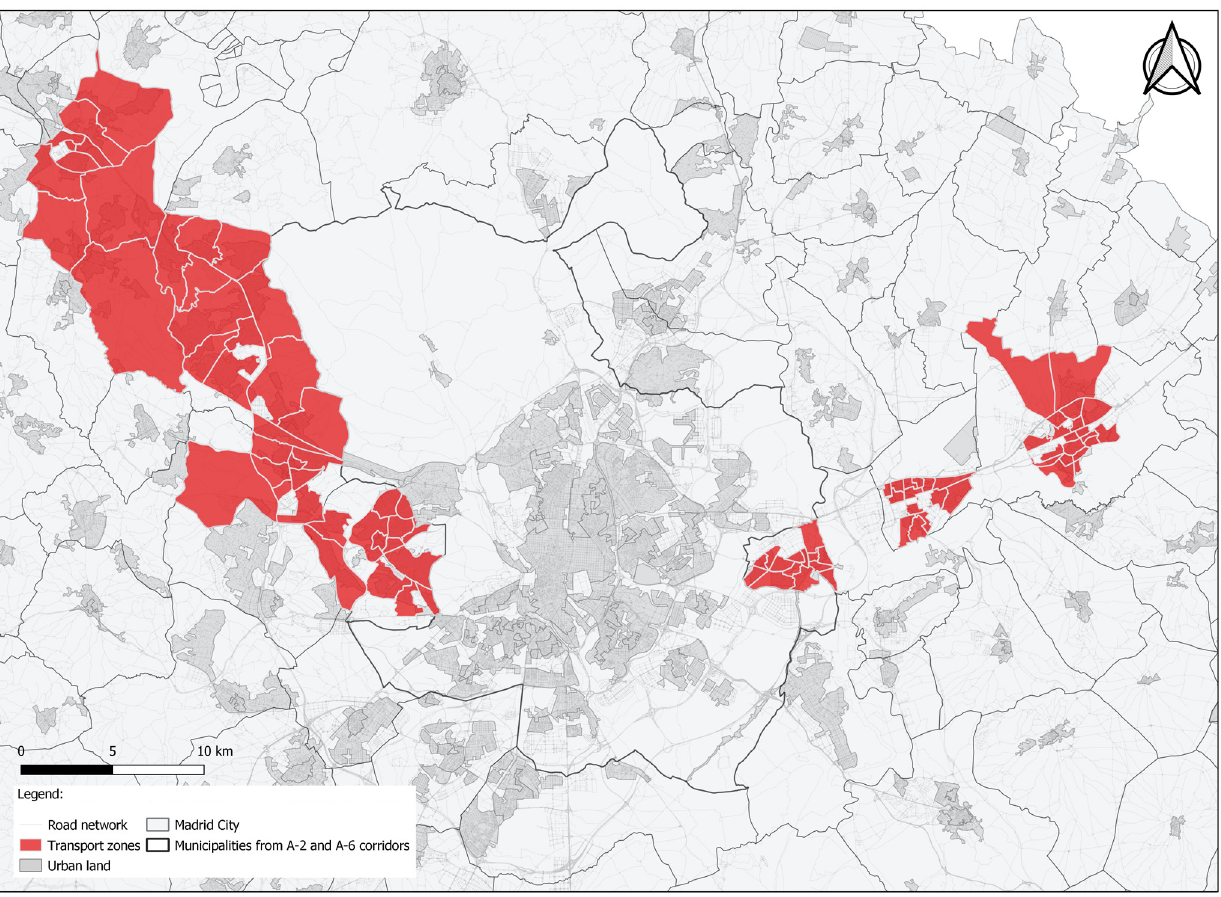
Figure 2. Transport zones (delimited in HMS-2018) vs. administrative boundaries (municipalities) of A6 and A2 transport corridors. (QGIS Software).